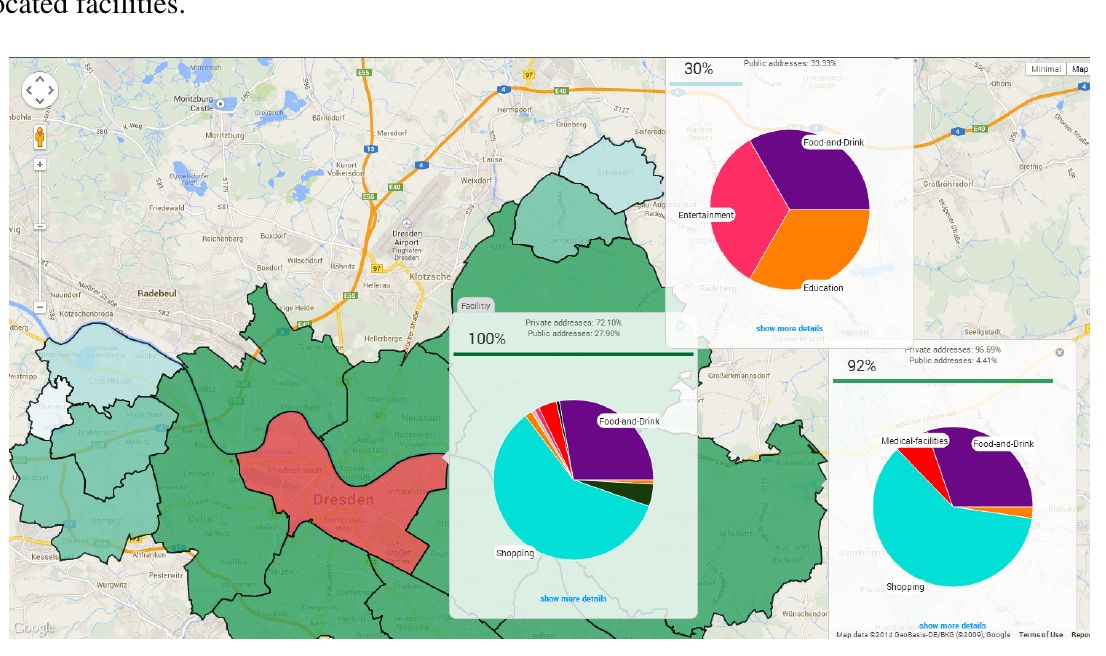
Figure 5 . Spatial overview of districts.